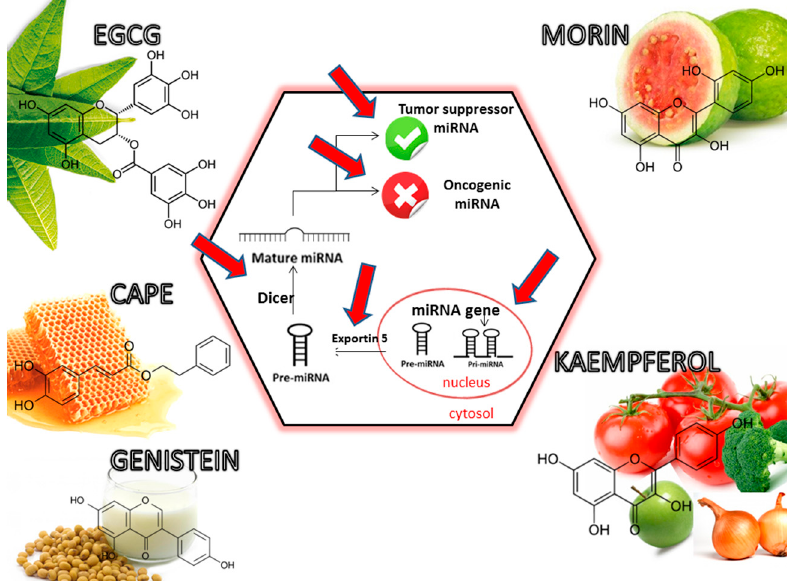
Figure 4. Effects of phytochemicals on regulation the expression of tumour suppressor miRNA and oncomiRNA, with important significance in tumoural pathology. Red arrows display multiple interventional targets of selected phytochemicals on miRNA biogenesis, with important role in the modulation of physiological and pathological processes.